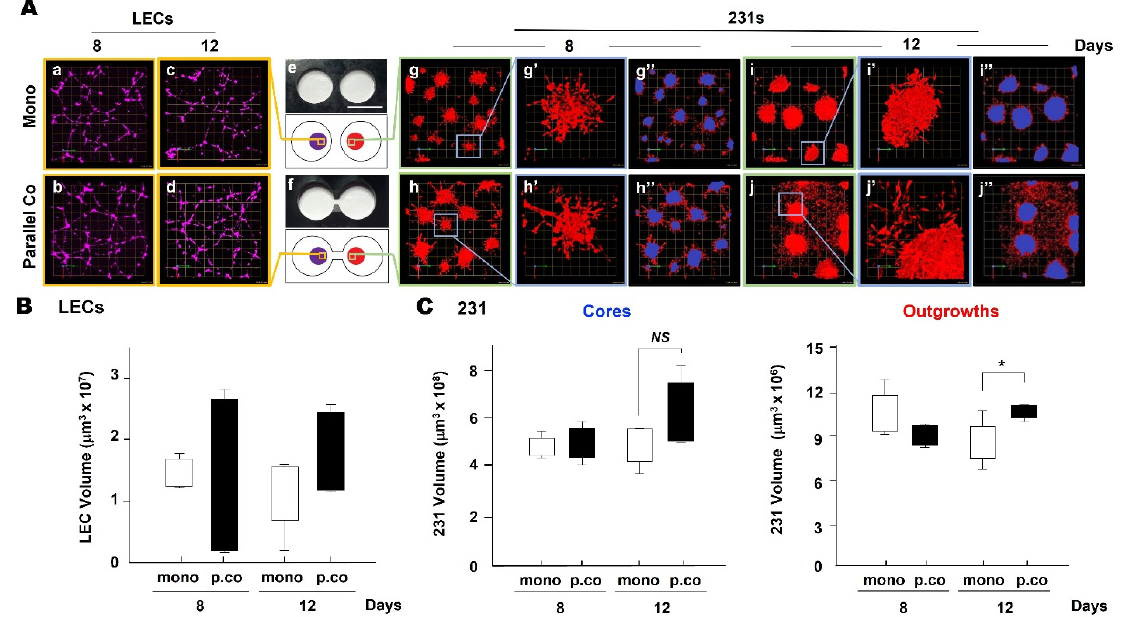
Figure 6. Multicellular invasive outgrowths from 231 spheroids are induced over a 12-day period in parallel 3D cocultures of 231 spheroids and LEC networks in TAME linked-well chambers. ( A ) Photos (top e, f) and schematics (bottom e, f) of TAME chambers with separate (top row) or linked (bottom row) wells. En face views of 3D reconstructions of 3D monocultures (Mono) in separate-well chambers (top row) and parallel 3D cocultures (Parallel Co) in linked-well chambers (bottom row) of 231 s (red) and LECs MG (purple) on days 8 and 12. Images are a single field with each grid in a–d, g–j, and g”–j” representing 50 μ m. Enlarged images (g’–j’) illustrate TNBC spheroids in greater detail; each grid represents 10 μ m. Scale bar in e represents 1.6 cm. ( B ) Total LEC volumes when grown alone (mono) or in parallel coculture (p.co) with 231 s were quantified at days 8 and 12 with Volocity ( n = 3). ( C ) Volumes of central cores and invasive outgrowths formed by 231 cells in 3D monoculture (mono) or parallel 3D coculture (p.co) with LECs at days 8 and 12 were quantified with Volocity as previously described [70]. * p ≤ 0.05; NS, not significant.